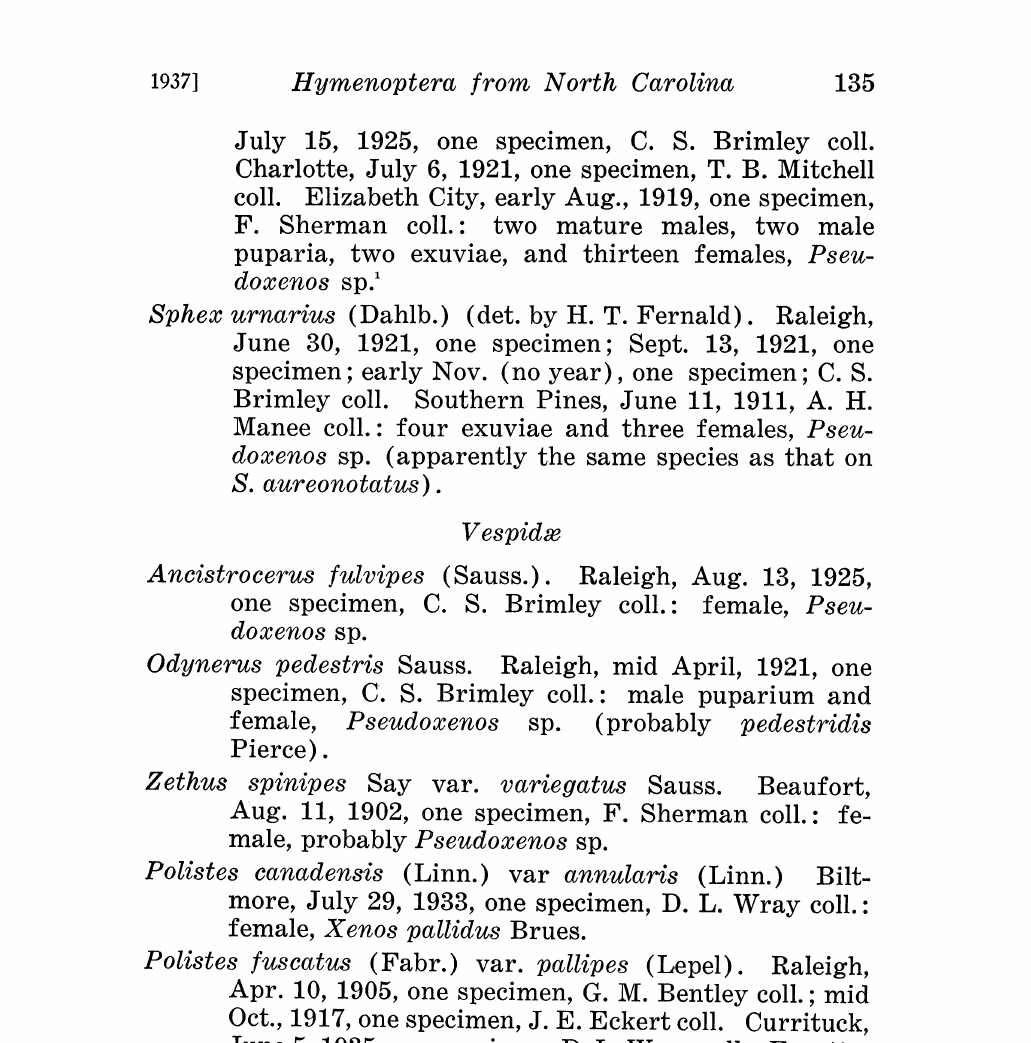
Refer to Eupathocera Pierce in the synopsis of this